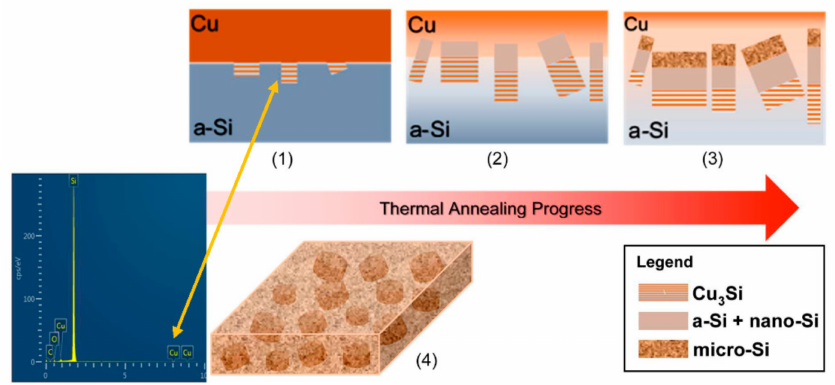
Figure 13. Illustration of the principle and mechanism of micro-Si film fabrication by